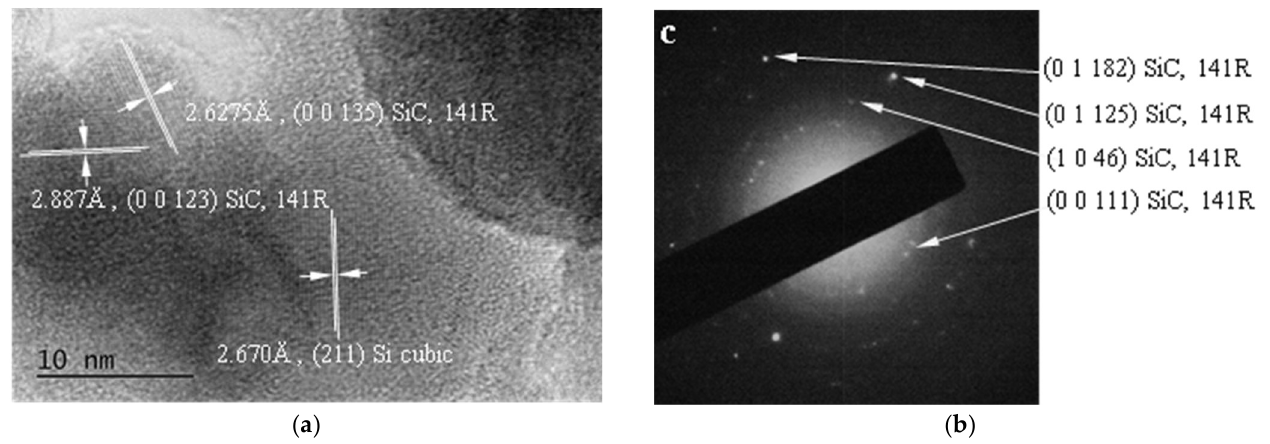
Figure 3. HRTEM ( a ) and SAED ( b ) images of the plasma plume products deposited on copper grids during the ns-laser ablation of PDMS in air with 266 nm and fluence ~4 J.cm −2 reveal presence of polycrystalline SiC and crystal Si phases.